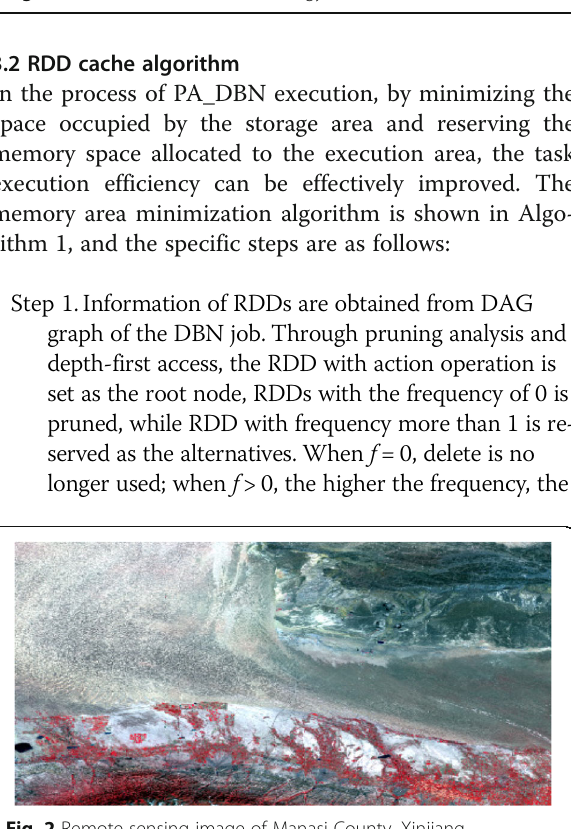
Fig. 1 Flow chart of a PA_DBN